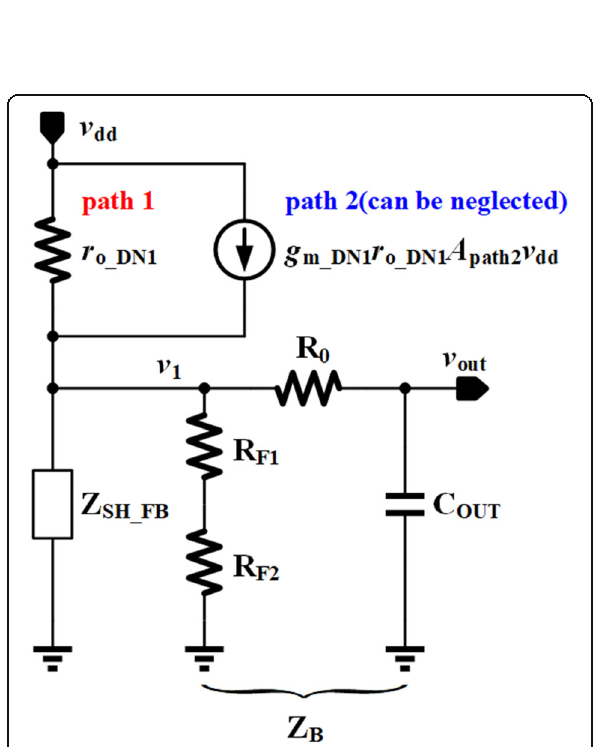
Fig. 8 The simplified model of PSR